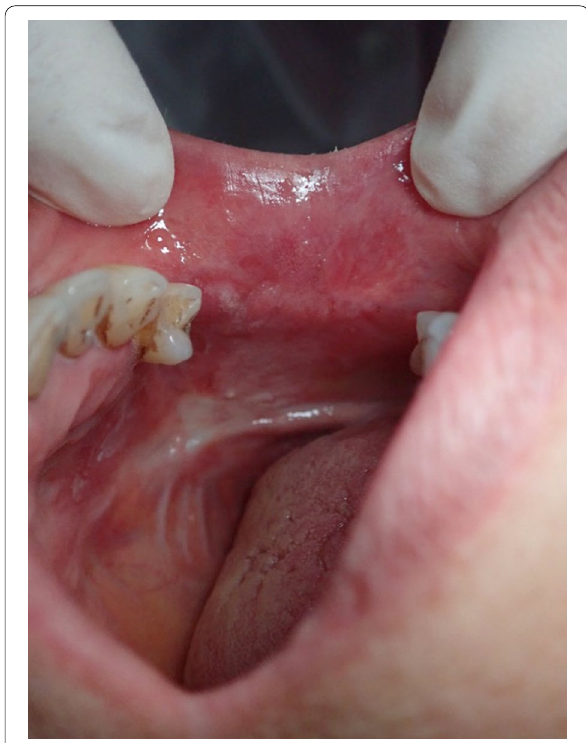
Fig. 4 The manifestations of oral cavity after the treatment for 18